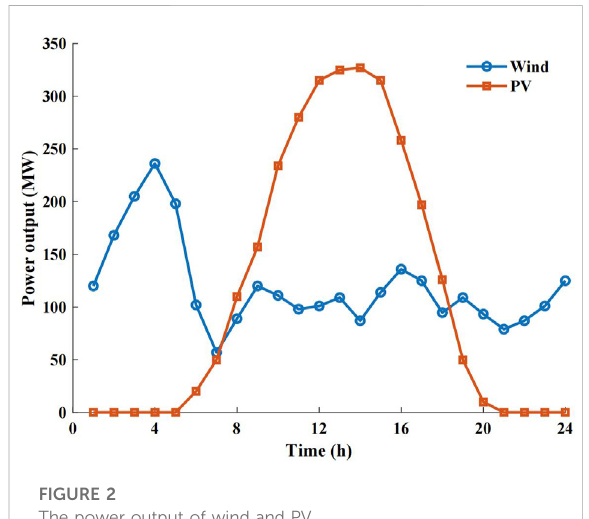
FIGURE 2 The power output of wind and PV.